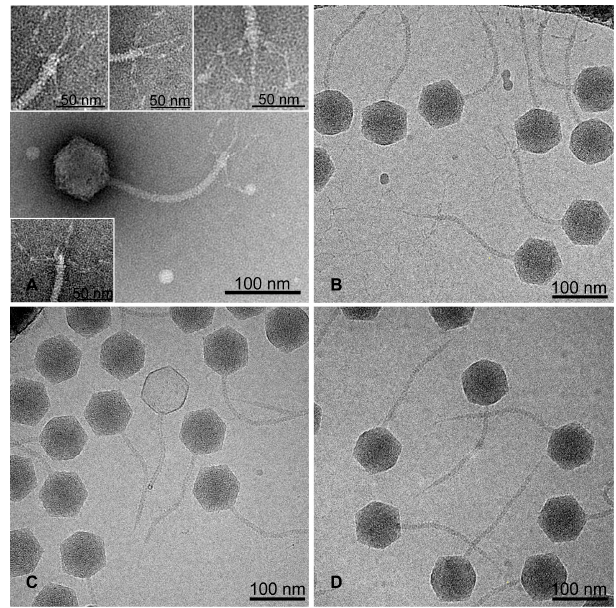
Figure 5. The morphology of DT571/2 phage and its ltf mutants. A . wild type phage (wt) negative staining; B . wt cryo-EM; C. ltfA − cryo-EM; D. ltfB − cryo-EM. The morphology of the wt LTFs appears